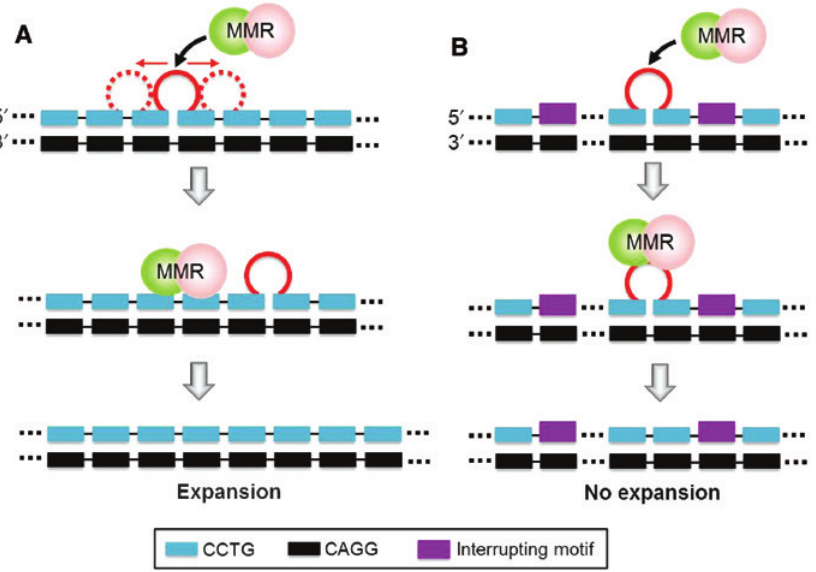
Figure 8: Shifting of the mini-loop provides more efficient escape from MMR. (A) In the uninterrupted CCTG repeat tract of DM2 patients, the mini-loop can shift in both the 5 ′ and 3 ′ directions, making it more easily to escape from MMR. (B) In normal individuals, the presence of interrupting motif(s) in the CCTG repeat tract will hinder the shifting of mini- loop. Thereby, the mini-loop can be recognized and removed more efficiently by the MMR